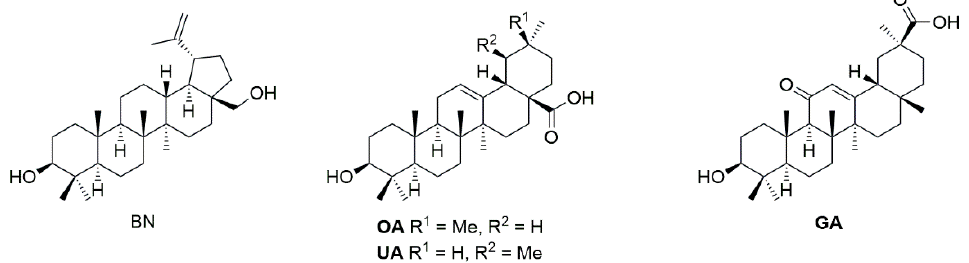
Figure 2. Structures of starting materials betulin (BN), oleanolic acid (OA), ursolic acid (UA), and glycyrrhetinic acid (GA).